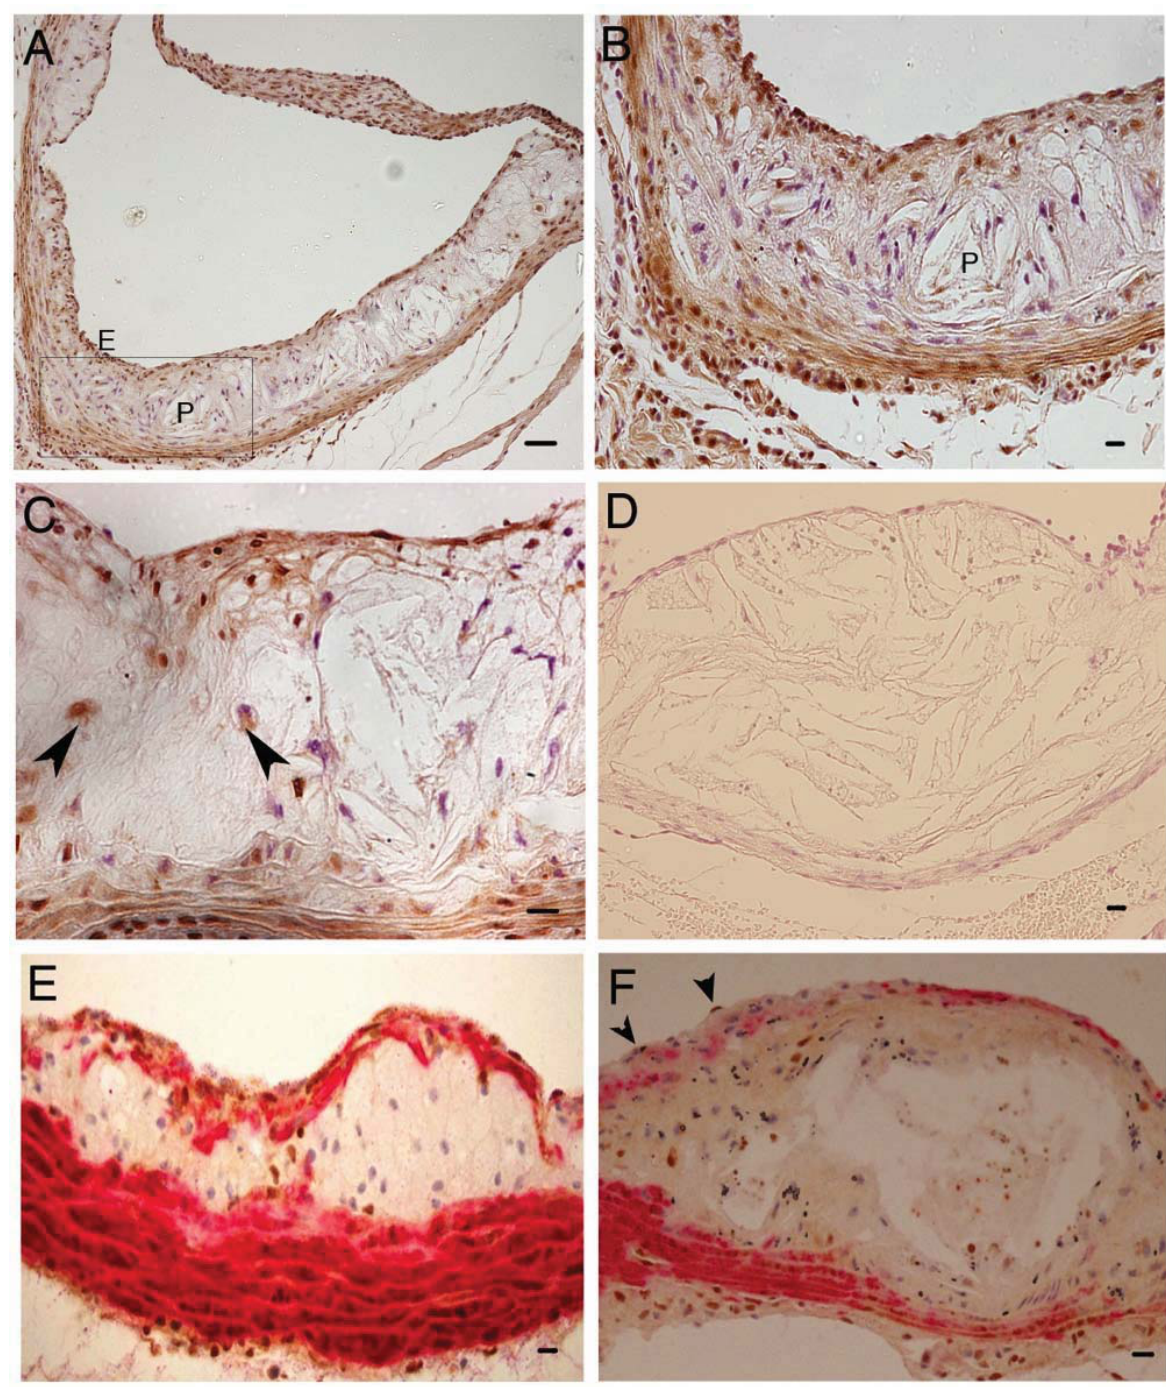
Figure 1. Tribbles 1 (trb-1) expression in experimental mouse atherosclerosis. A Trb1 expression (brown) in the aortic sinus P (plaque), E (endothelium); B High power of boxed inset from A, P (plaque); C Trb-1 expression in endothelium, some macrophages (arrows); D negative control (secondary Ab only); E dual staining for trb-1 (brown) and Smooth Muscle Cell Actin (red); F as E with some trb staining in endothelium (arrows). Note: some cells express trb-1 but not SMA and are probably